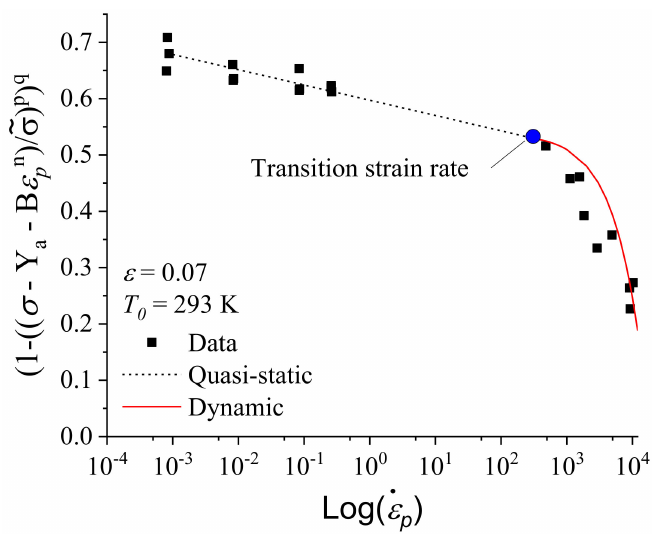
Figure 11. Determination of β 1 and β 2 using mixed approach and Equation (10) to describe the continuity condition.